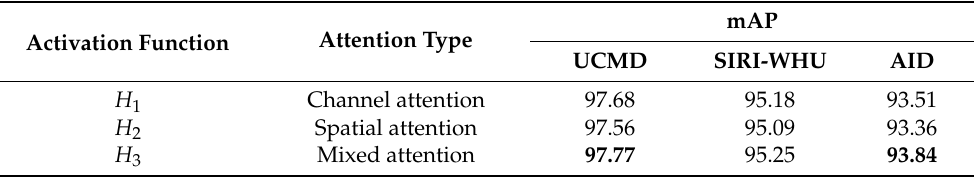
Table 1. mAP (%) for RSIR when three attention functions are used in the proposed architecture applied on UCMD, SIRI-WHU, and